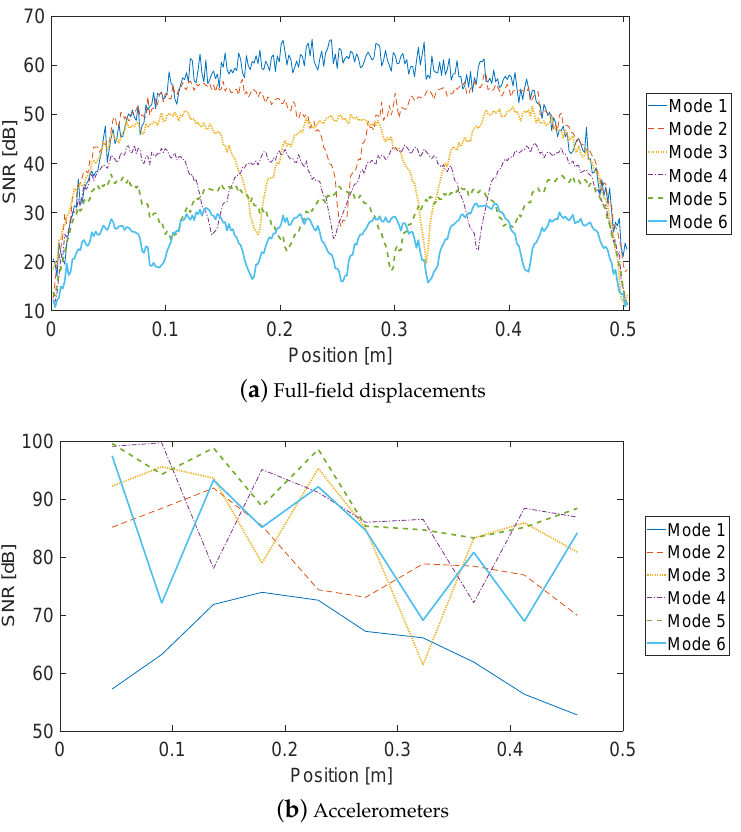
Figure 15. Signal-to-noise ratio (SNR), in dB, for different measurement types for the clamped– clamped beam: ( a ) full-field displacements and ( b ) accelerometers.